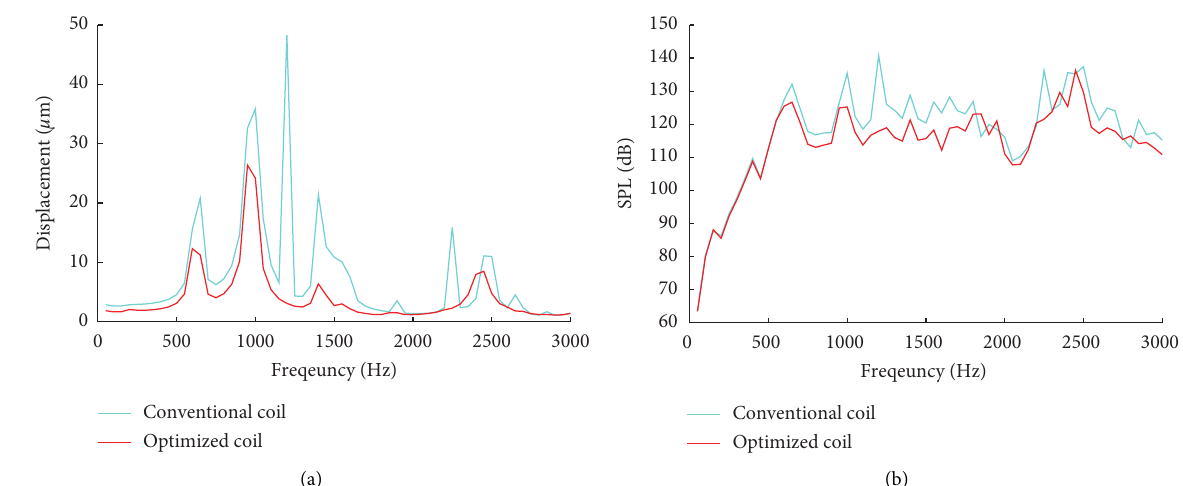
Figure 6: The (a) displacement of gradient coils and (b) corresponding average SPL in the patient bore over the frequency range from 0 to 3000Hz.